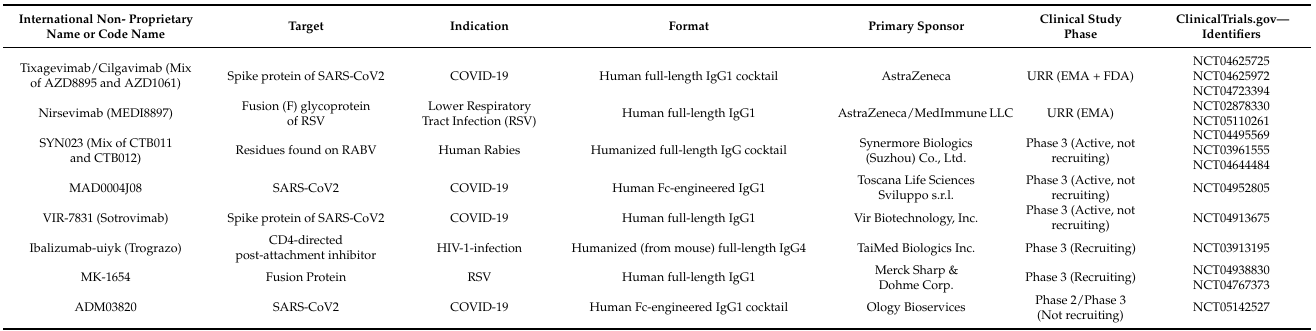
Table 3. Therapeutic antibodies delivered by IM administration, currently undergoing